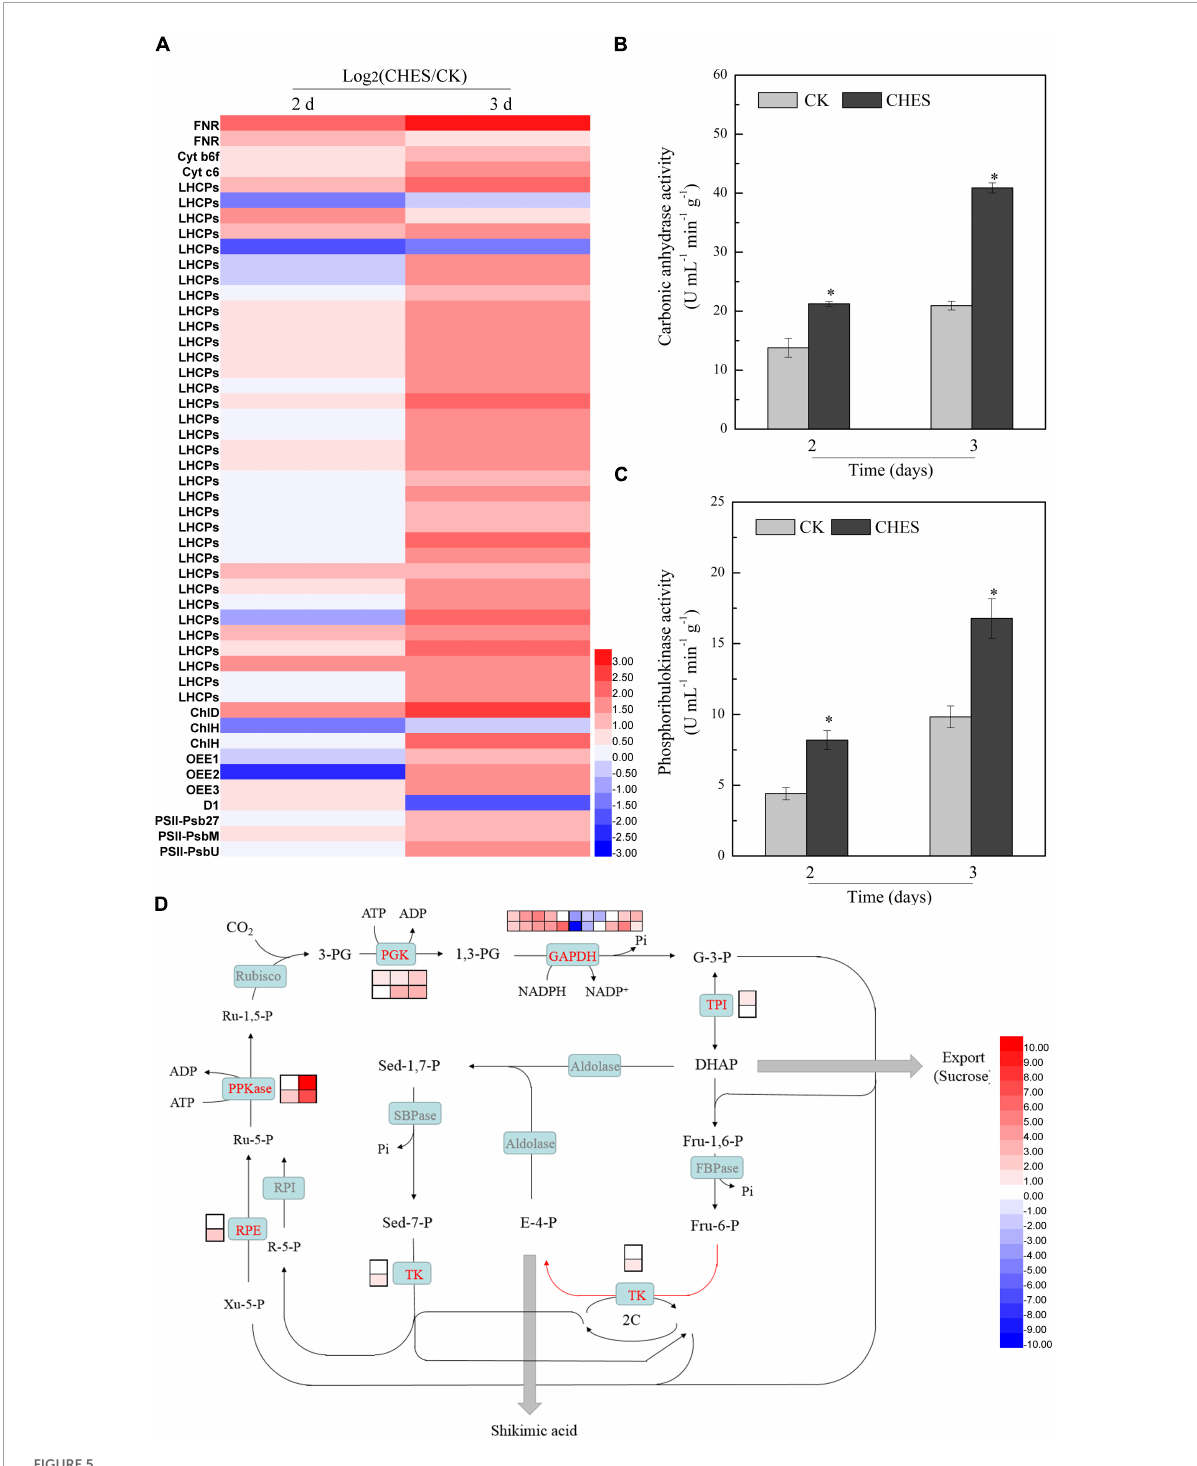
FIGURE5 Changes in photosynthesis under CHES treatment in P. tricornutum . (A) The expression of gene involved in photoreaction were determined by RNA-Seq in 2 and 3 days after culture. (B,C) The activity of carbonic anhydrase and phosphoribulokinase were determined by ELISA Kit in 2 and 3 days after culture. Each bar represents three replications. Values represent mean ± SD ( n = 3). (D) The expression of gene involved in C3 fixation reaction were determined by RNA-Seq in 2 and 3 days after culture. The upper and lower panels were determined in 2 and 3 days after culture,